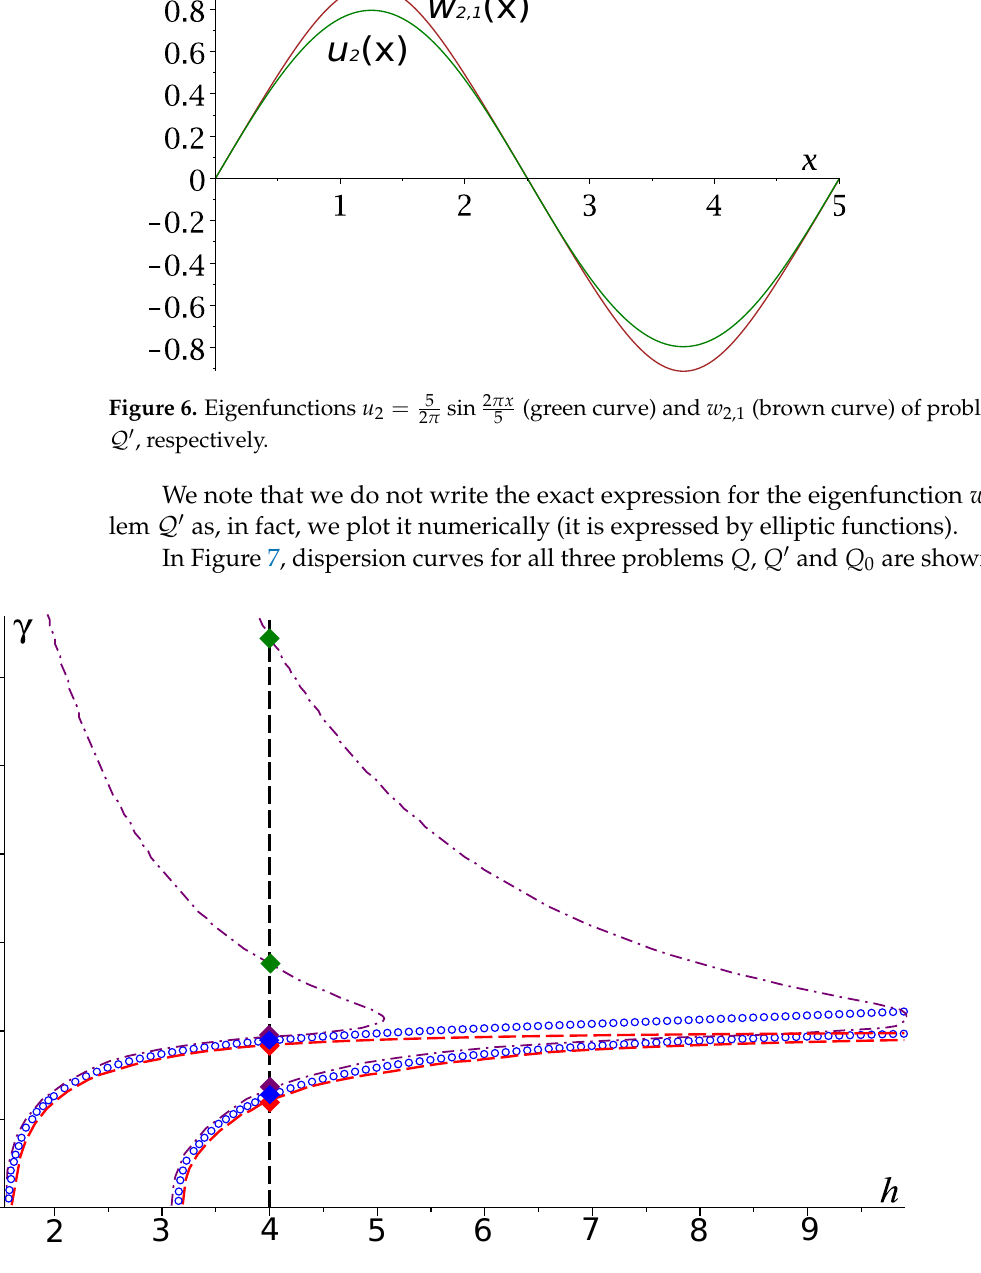
(blue curves), (purple curves) and Q Q (cid:48)